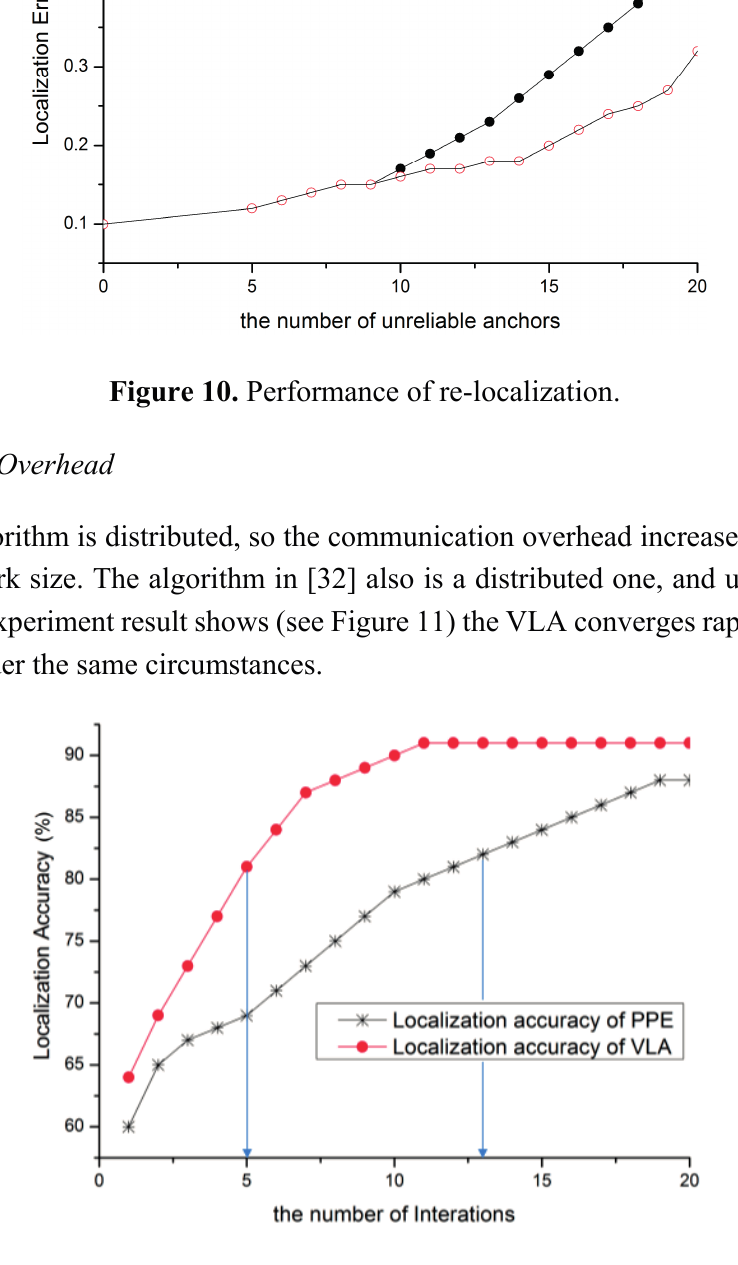
Figure 11. Comparison of communication